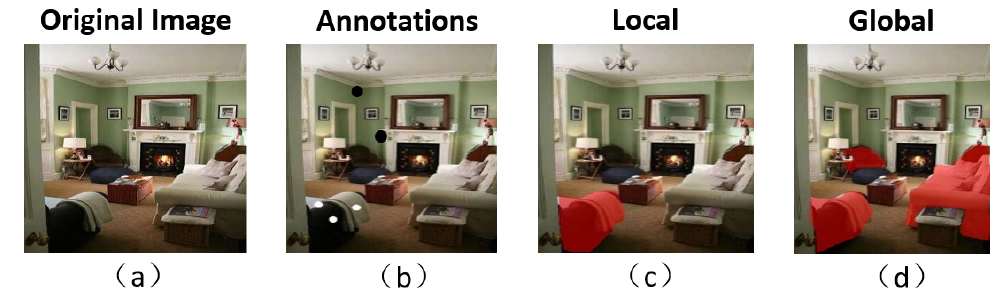
Figure 5. Global pooling the task representation in the guidance branch. In this case, we annotate a single sofa ( b ) on the original image ( a ), but global guidance causes all the sofas to be segmented ( d ) instead of obtaining one sofa ( c